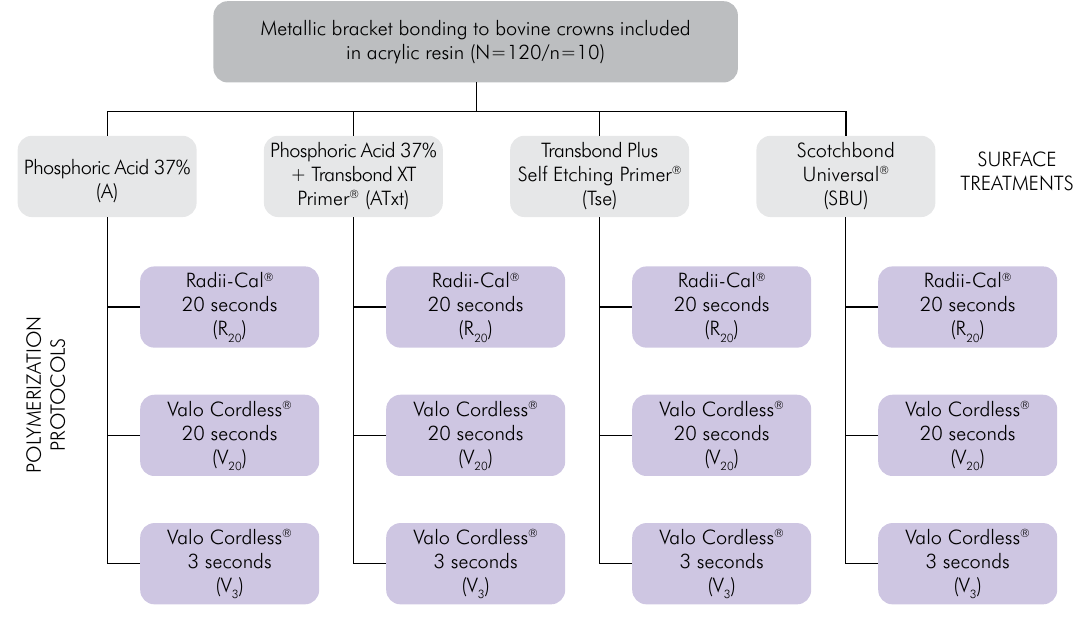
Figure 1. Flowchart indicating surface treatments and polymerization protocols performed during bracket